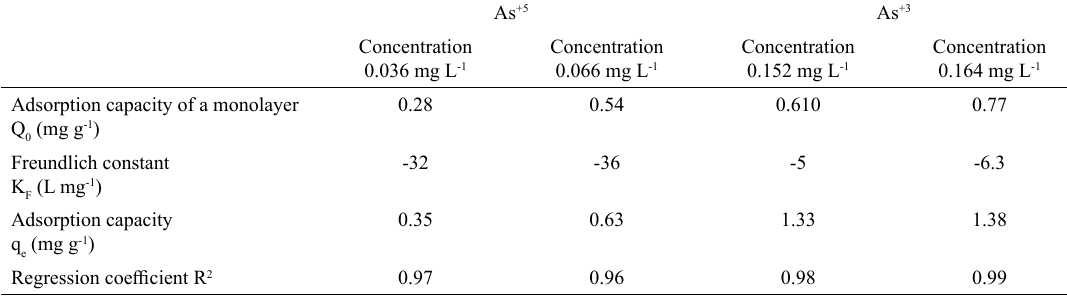
Table 6: Results from the Freundlich model for the adsorption of As ions (As +3 y As +5 ) on the MNPs.